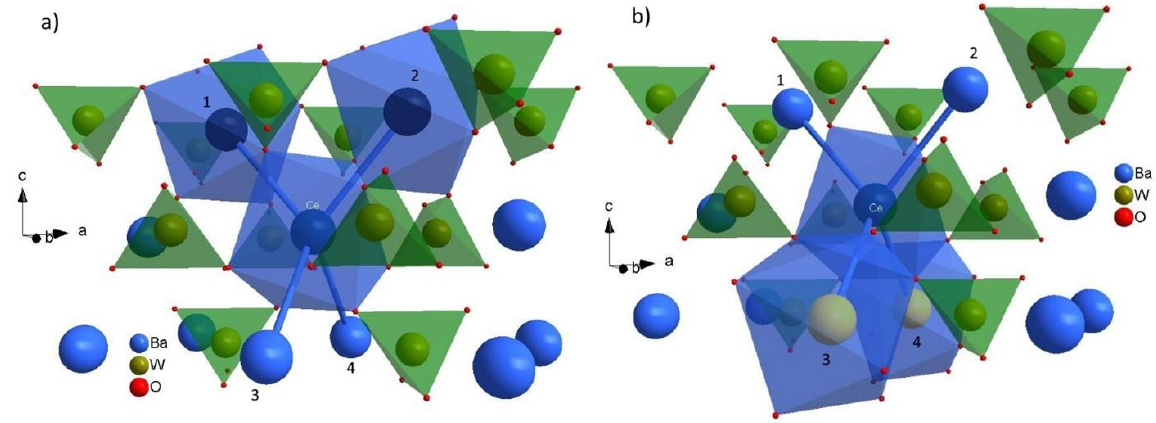
Figure 4. [CeBa 4 ] tetrahedron in two cases. ( a ) The two barium vacancies ( 𝑉 𝐵𝑎2− ) in the barium sites 1 and 2 are marked with a dark blue color (the left picture). ( b ) The two sodium ions in the barium sites 3 and 4 ( 𝑁𝑎 𝐵𝑎+ ) are marked with yellow color (the right picture).